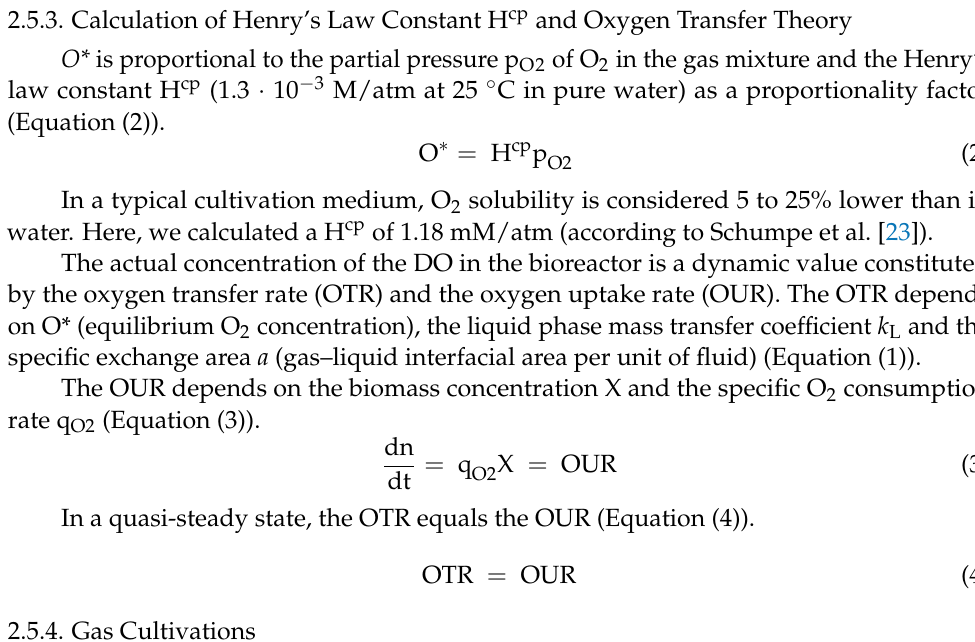
Figure 2. Explosion-proof bioreactor setup consisting of a 1 L DURAN ® bottle with a magnetic anchor stirrer on a magnetic stirrer plate. Gas substrate is supplied by a steel tube with a PTFE frit at the